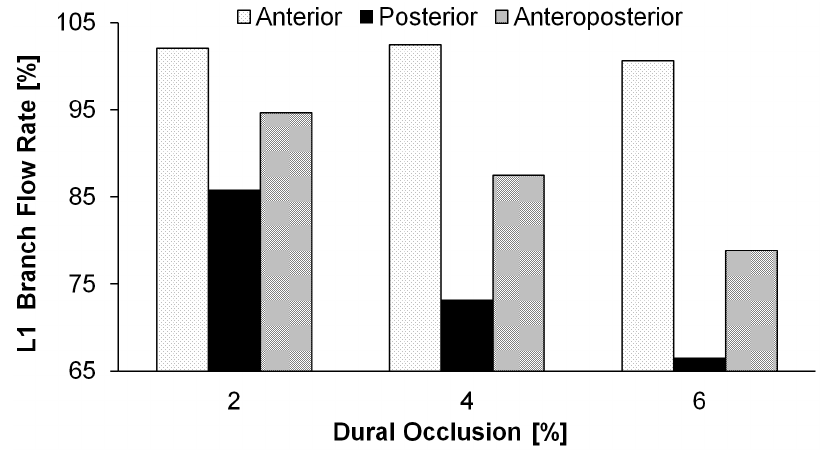
Figure 5. Retained L1 branch volumetric blood flow rate under various modes of spinal compression. Under equivalent degrees of dural occlusion, the induced reduction of branch blood flow rate varies with the orientation of compression.